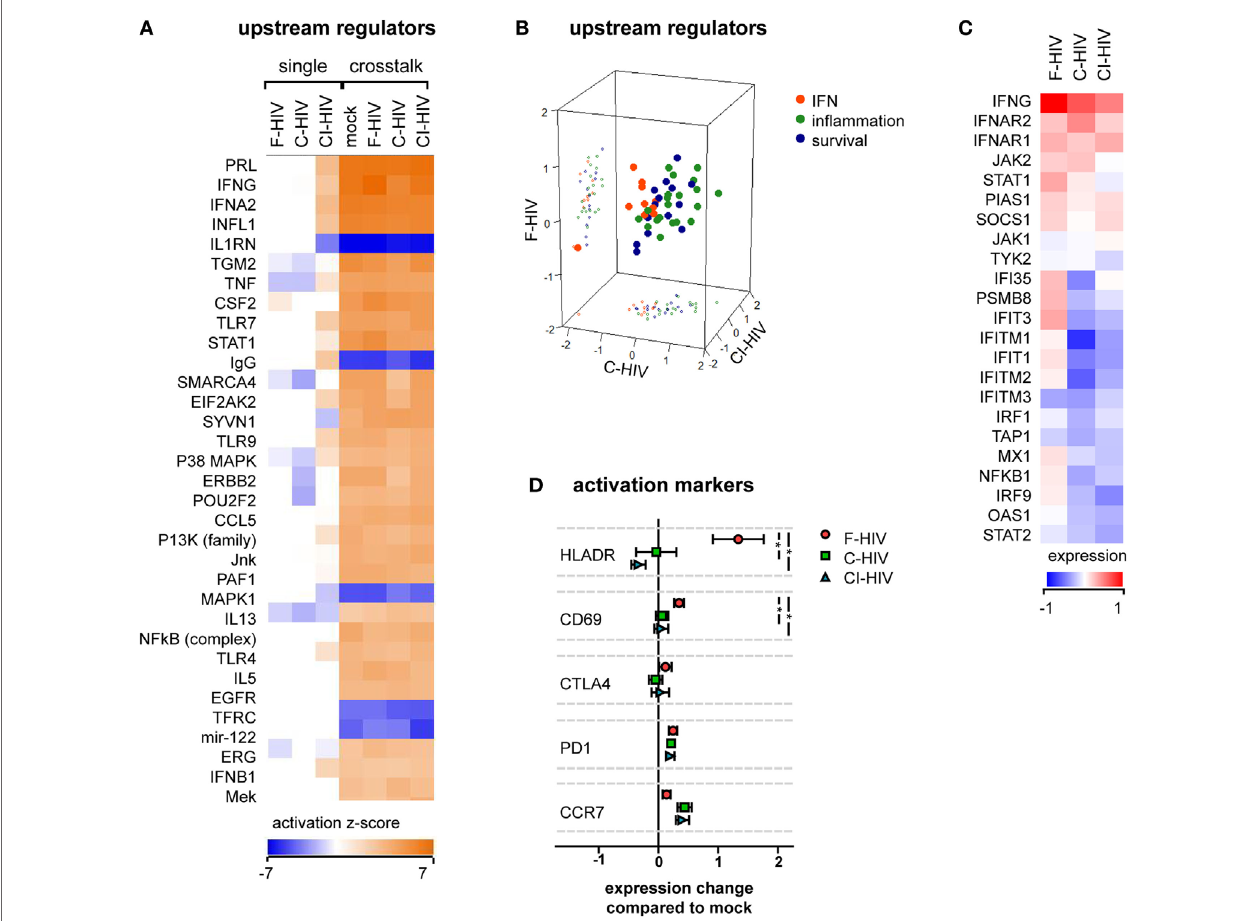
FigUre 3 | HIV effects on natural killer (NK) cell activation in the absence or presence of dendritic cells (DCs). NK cells were exposed to 1 μ g/ml F-HIV, complement-opsonized HIV (C-HIV), CI-HIV either in single NK cell culture, or in a cross talk culture consisting of NK cells and DCs from the same donor at a 1:1 ratio. The experiment was replicated three times using cells derived from three different donors. (a) RNAseq was performed on the NK cells from the single culture or NK cells isolated from the NK–DC cross talk, and the genes that were significantly differentially expressed were analyzed using IPA (Qiagen) to determine the most affected upstream regulators. (B) The top upstream regulators were divided into functional groups, and a 3D scatterplot was used to visualize clustering. (c) A heatmap was generated for genes that were significantly differentially expressed in at least one condition and that were defined by IPA to be involved in IFN signaling. The heatmap shows fold change in the virus exposed cross talk samples compared to the mock-treated cross talk samples. (D) The protein expression of activation markers on the NK cells from the cross talk cultures was assessed using flow cytometry, and normalized to the expression in the mock-treated